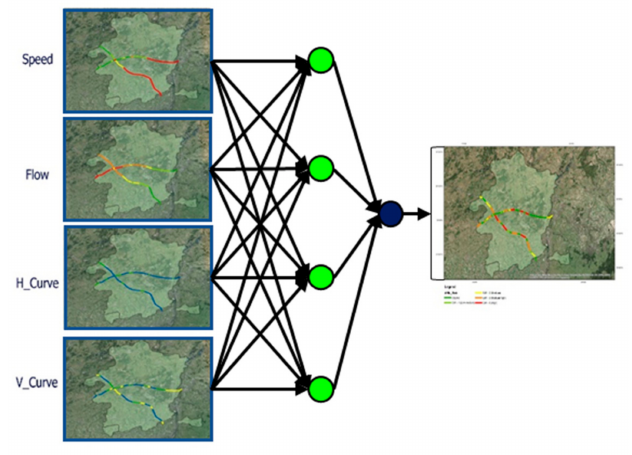
Figure 3. Risk Prediction GIS Map based on the ANNs